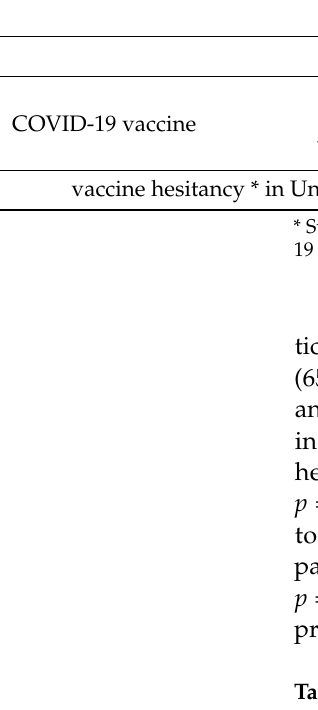
Table 2. Difference in hesitancy according to the participants characteristics by survey